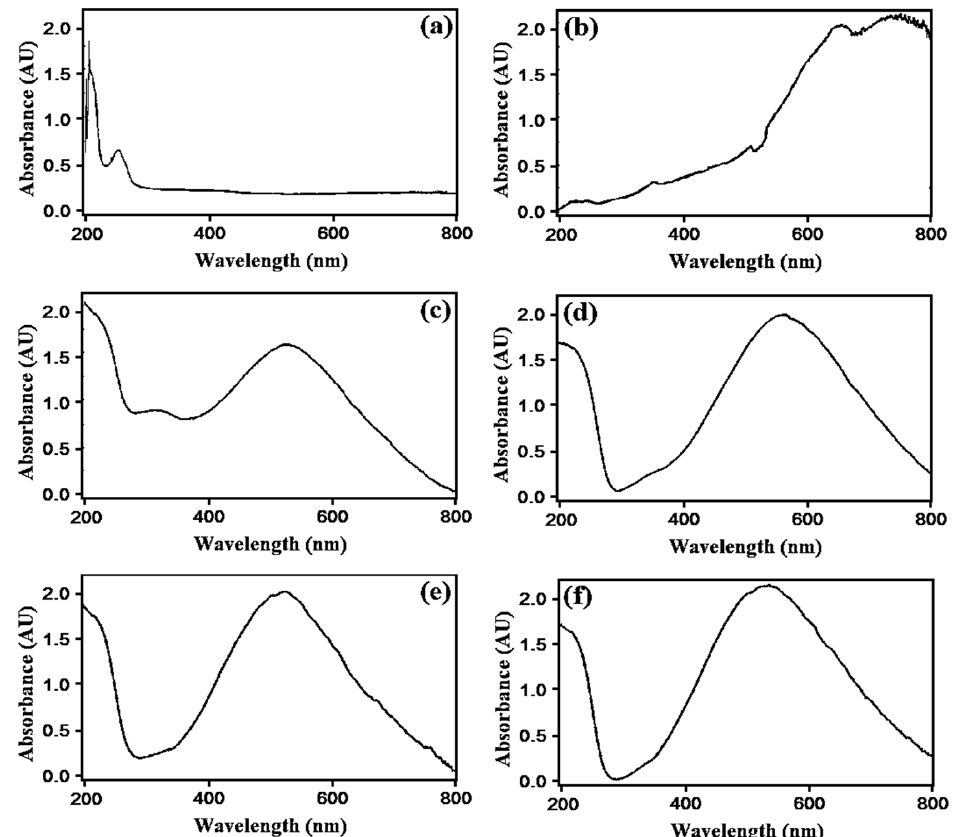
Figure 3. UV-visible spectra of ( a ) pure POA, ( b ) 1% of POA/BaSO 4 , ( c ) 3% of POA/BaSO 4 , ( d ) 5% of POA/BaSO 4 , ( e ) 7% of POA/BaSO 4 , and ( f ) 10% of POA/BaSO 4 .